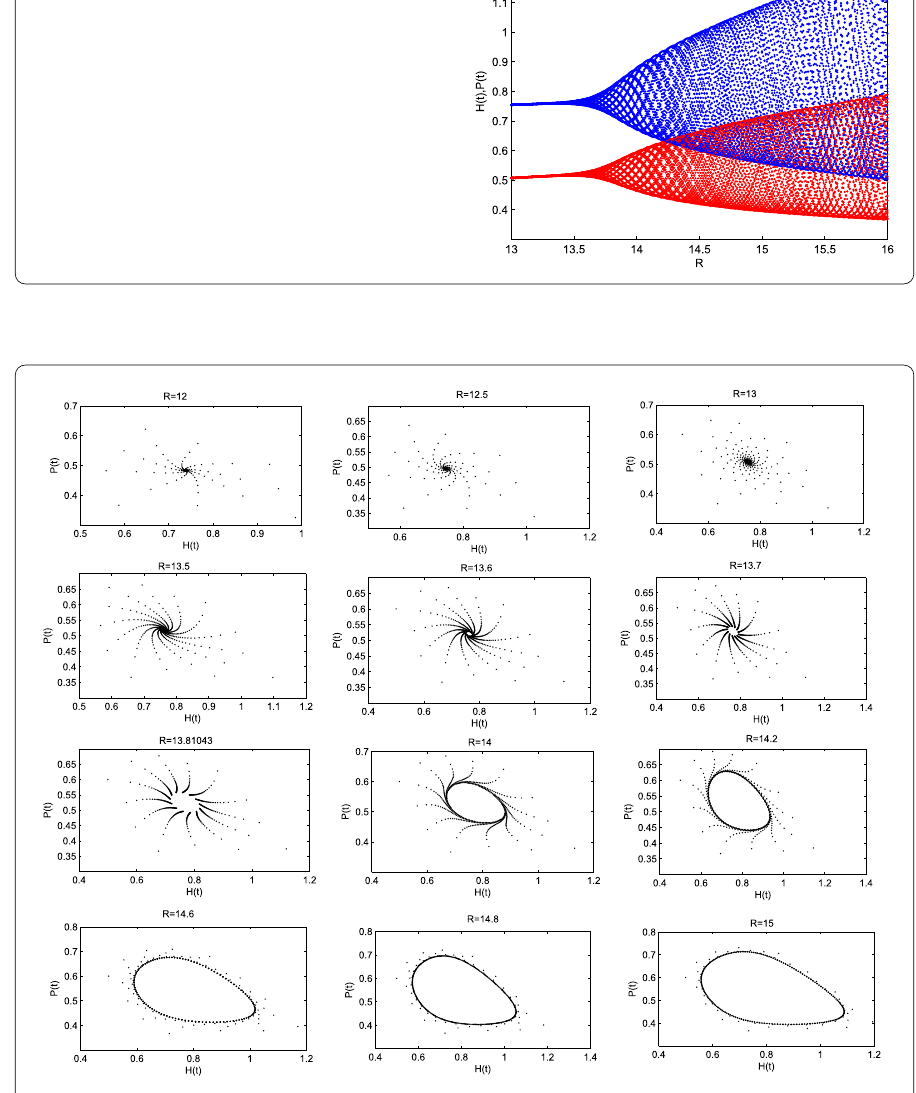
Figure 5 Phase portraits of the system (5) for values of R